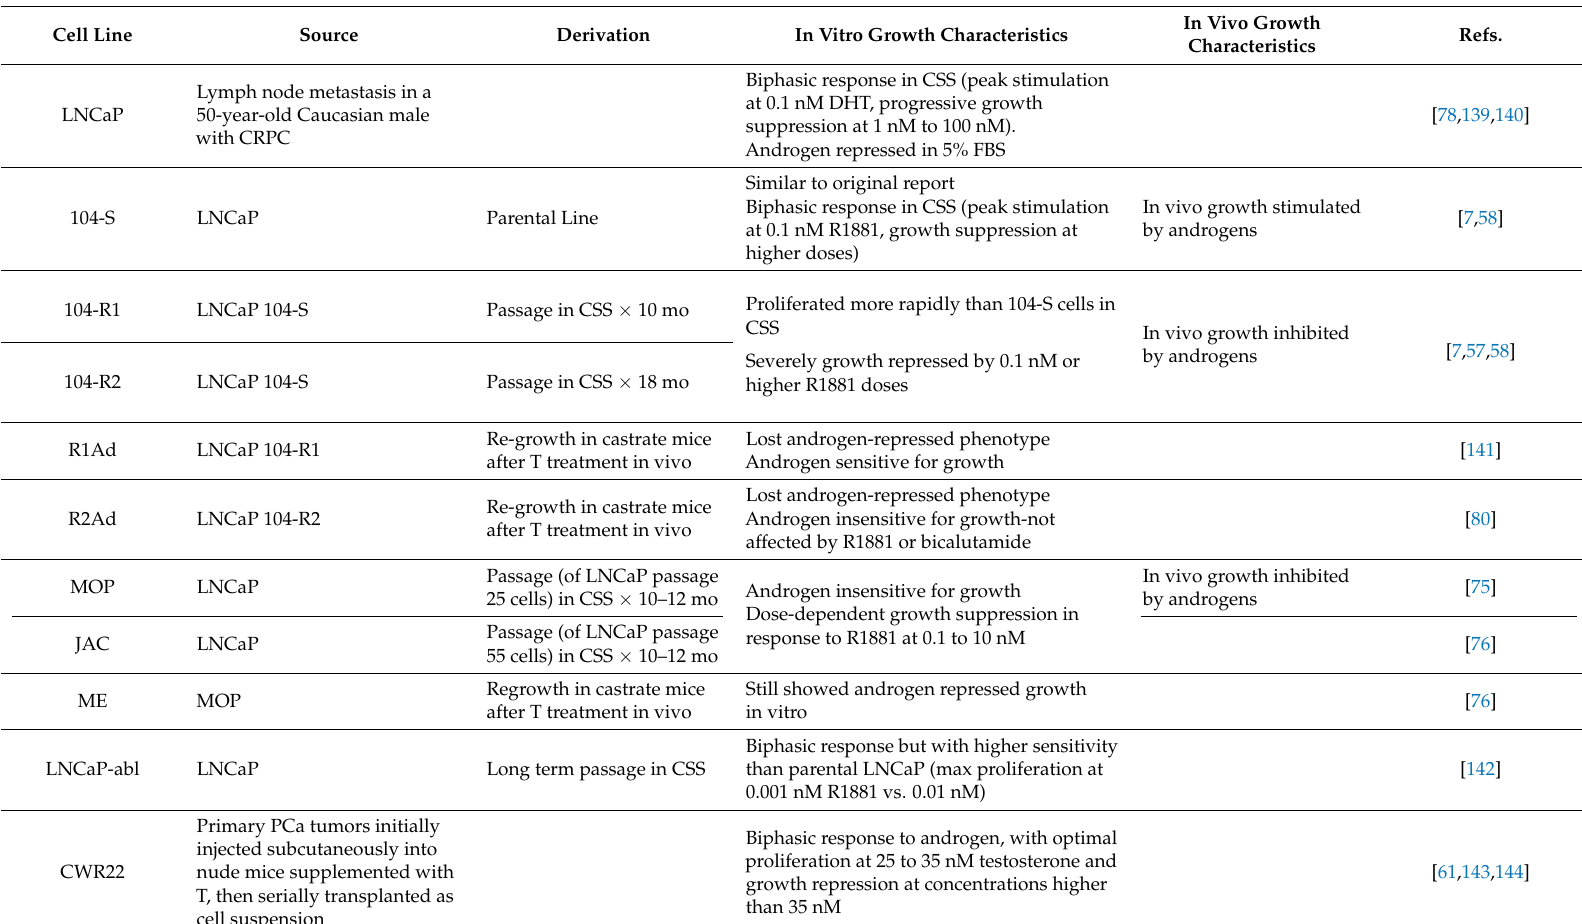
Table A1. Preclinical Responses to Androgen-Mediated Growth